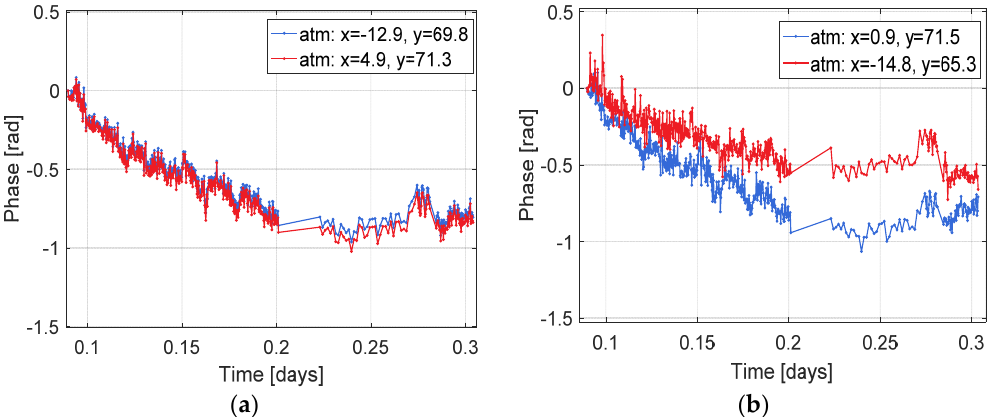
Figure 13. Atmospheric phase of the four representative PSs. (a) indicates points (-12.9, 69.8) and (4.9, 71.3); (b) indicates the point (1.3, 71.5) With (-14.8, 65.3).